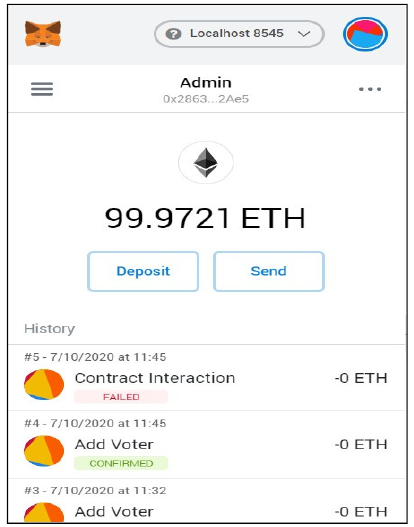
Figure 2. MetaMask Initial Eth Balance.